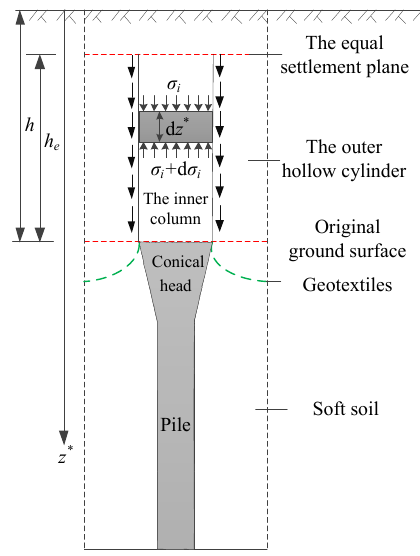
Figure 3. The cylindrical unit cell model.